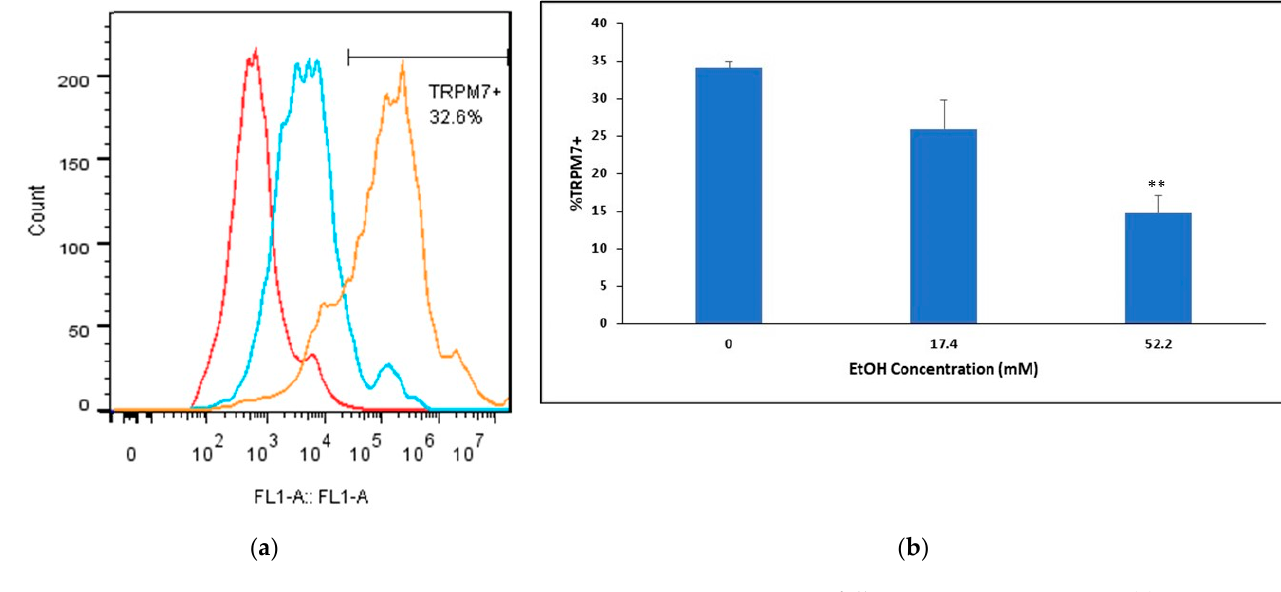
Figure 2. TRPM7 expression in mouse BMVECs following EtOH treatments: ( a ) Representative histograms of intracellular TRPM7. Mouse BMVECs were stained with primary TRPM7 Ab (orange), isotype control (blue), or unstained (red); ( b ) Mouse BMVECs treated with 17.4 mM EtOH, 52.2 mM EtOH, or no EtOH (control) for 24 h. Cells were stained for TRPM7 expression . ** p < 0.01.